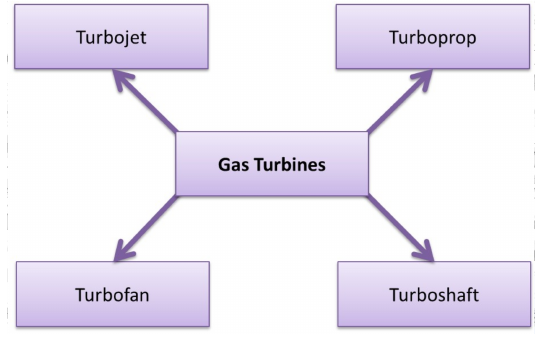
Figure 4. Types of gas turbine